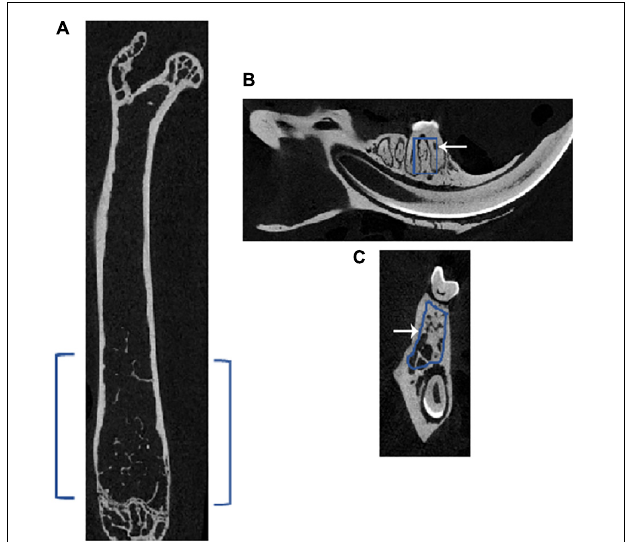
FIGURE 1 | Representative micro-CT image of a femur and mandible of a mouse showing the region of interest (ROI) for subsequent analyses. Micro-CT of (A) femur in the axial plane showing the selected ROI in blue brackets, and mandible shows the chosen ROI, outlined in blue in the (B) sagittal and (C) coronal sections; white arrow points to the outline. In the femur, the ROI for the trabecular bone lies just below the growth plate region, which is called the metaphyseal area, where cancellous or trabecular bones are present. In the mandible, the ROI was chosen in the inter-radicular area between the roots of the first